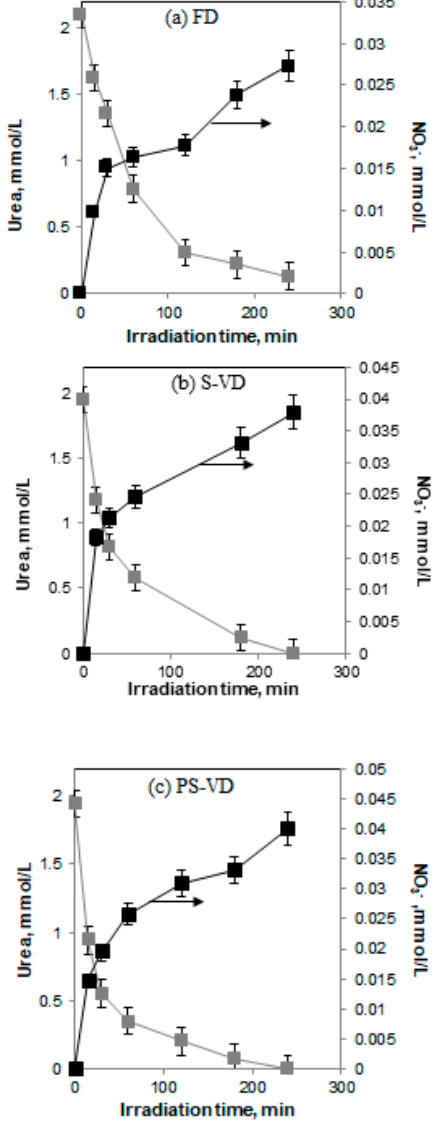
Figure 7. Behavior of urea and NO 3 − concentrations as a function of visible light irradiation time (after the dark period) obtained with FD LED dimming, S-VD LED dimming modulation, and PS-VD LED dimming modulation. Urea initial concentration: 250 mg / L in distilled water; solution volume: 250 mL; N-TiO 2 / PS amount: 120 g.